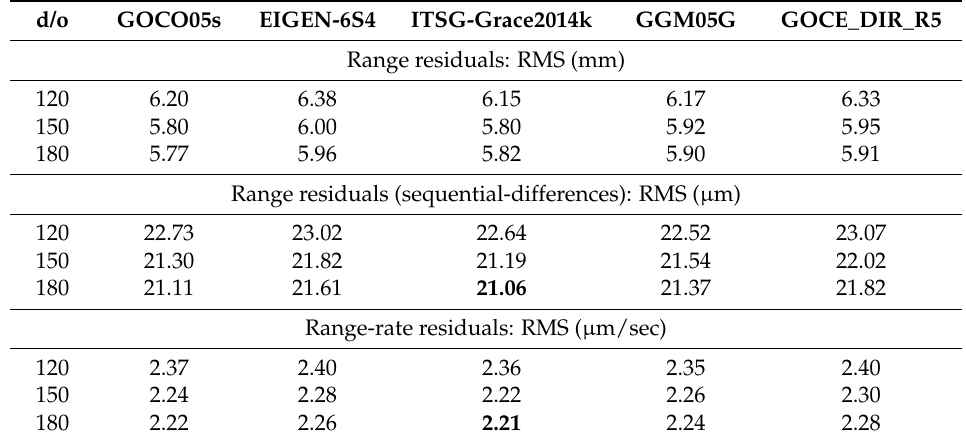
Table 3. K-band data residuals based on GRACE dynamic orbit determination. Range residuals are provided for the cases of the KBR bias estimation and elimination through sequential range differences.